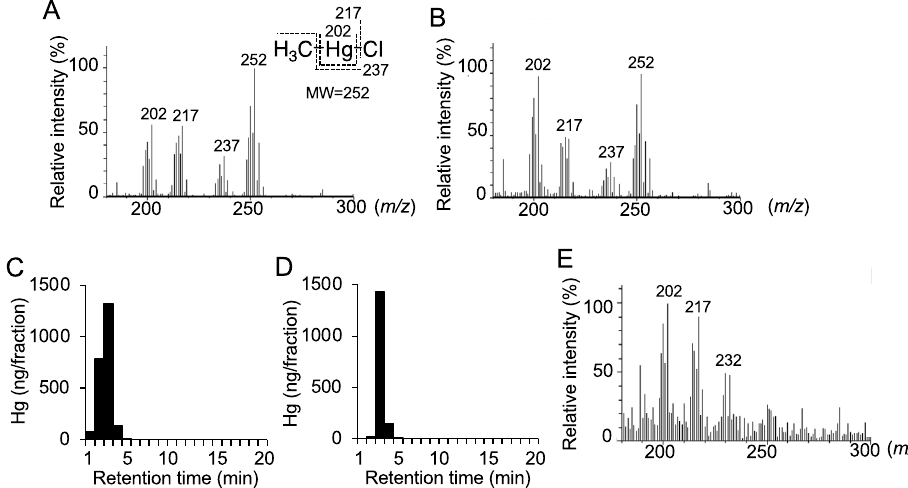
Figure 5. Detection of MeHg during incubation of dimethylmercury . MeHg or DMeHg were incubated in 0.5 N HCl-50% methanol for 4 days. EI-MS spectra of ( A ) authentic MeHgCl and ( B ) DMeHg. Hg levels of ( C ) MeHg and ( D ) DMeHg solution were detected by HPLC/AAS analysis. ( E ) EI-MS spectrum of DMeHg in